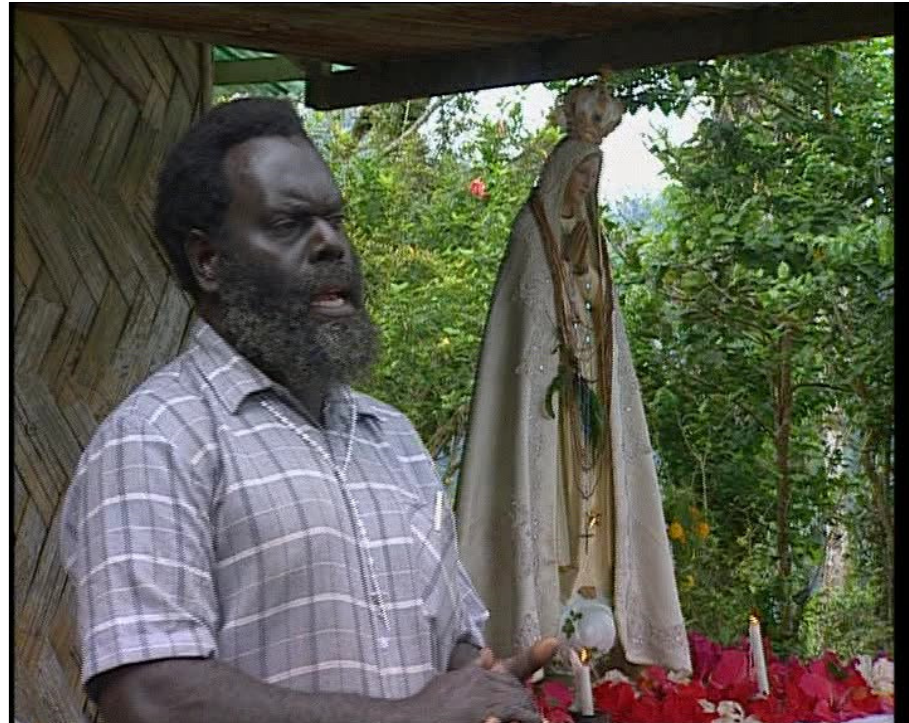
Figure 1. The International Pilgrim Virgin Statue of Fatima with Francis Ona in Guava village, Bougainville, in 1997. Fragment from the film “Pilgrim of Peace, made by Fr. Zdzislaw Mlak (Courtesy of Fr. Zdzislaw Mlak).